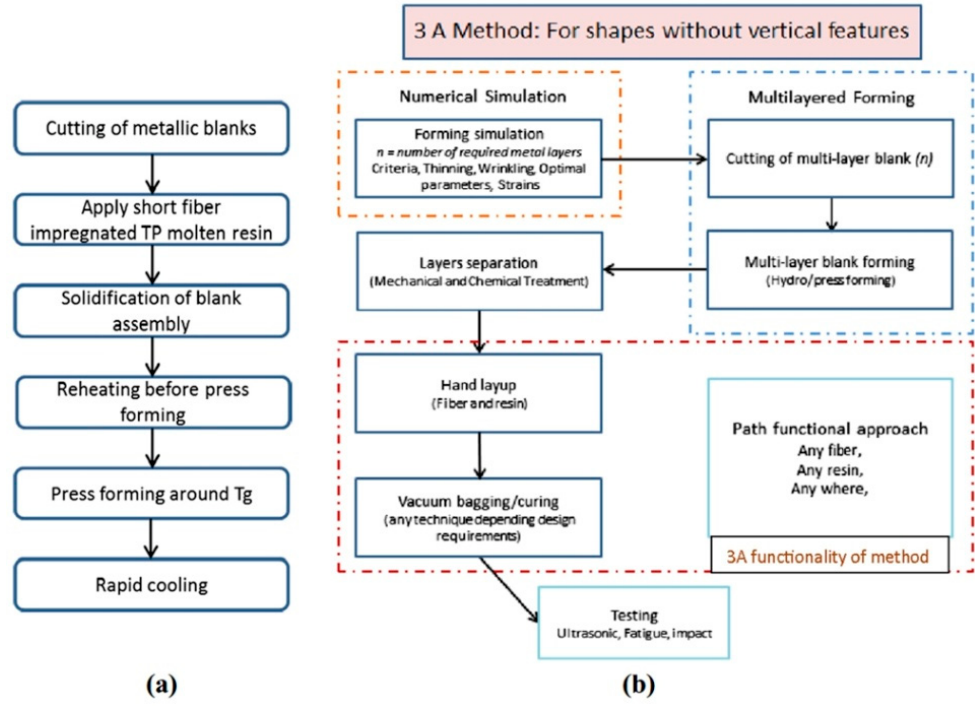
Figure 37. ( a ) Existing and ( b ) novel 3A method (reprinted with permission from [383]; copyright© 2021, Springer ‐ Verlag France).